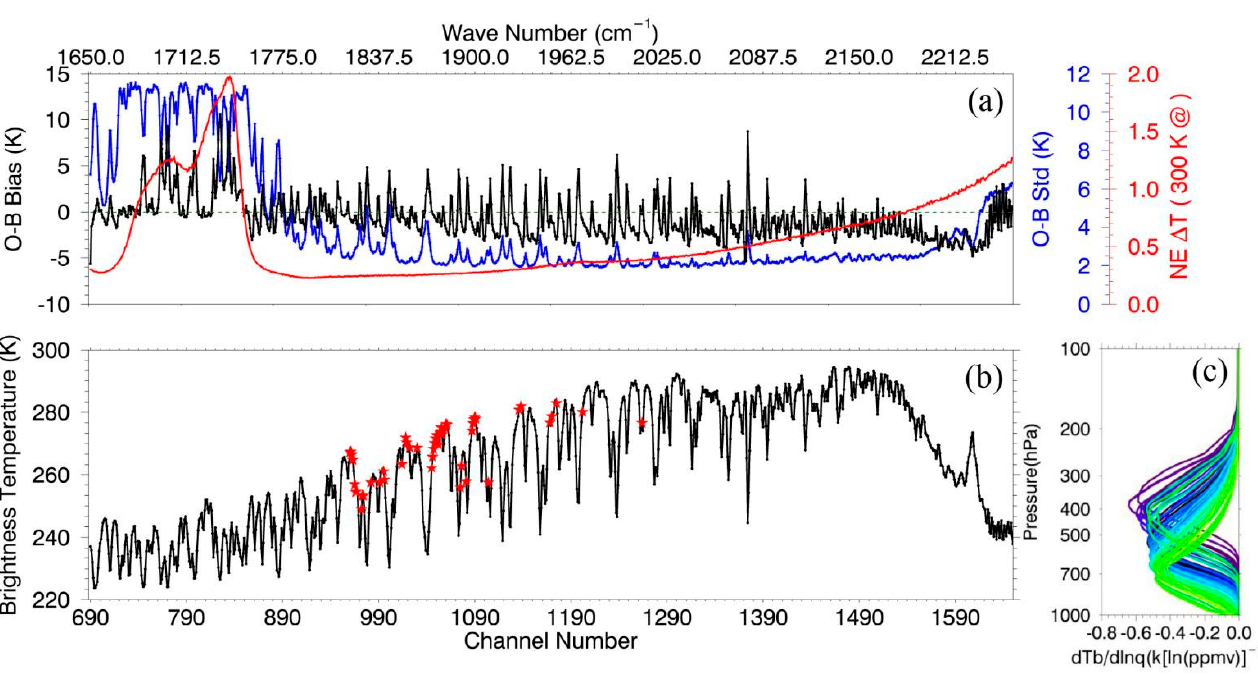
Figure 1. ( a ) Bias characteristics and ( b ) brightness temperature of GIIRS MWIR channels, and ( c ) the humidity Jacobians of selected channels.